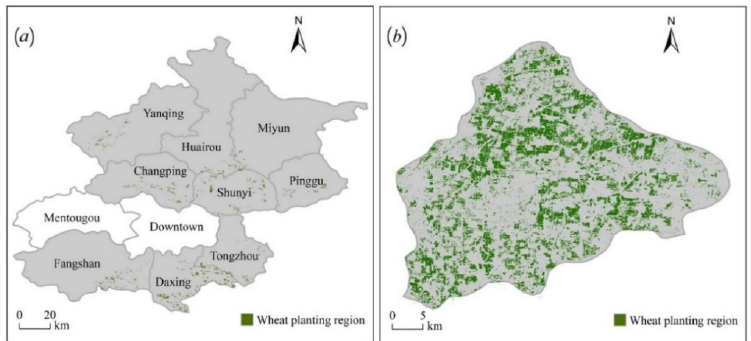
Figure 6. Classification map of winter wheat in Beijing City and Renqiu City: ( a ) Beijing City; ( b ) Renqiu City. No wheat was planted in the white administrative area.